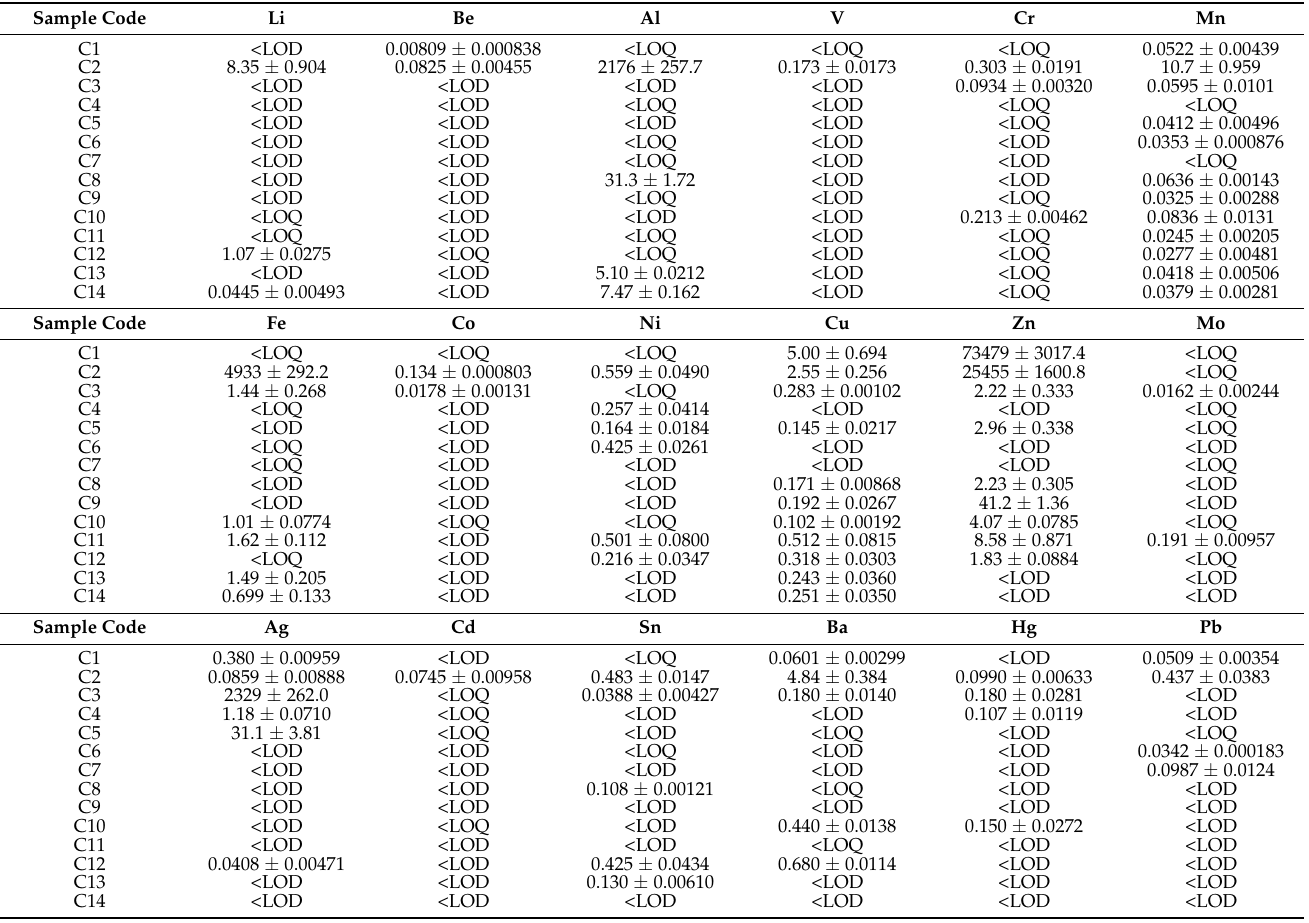
Table 4. Concentration ( µ g g − 1 ) of the studied metals in commercial moisturising